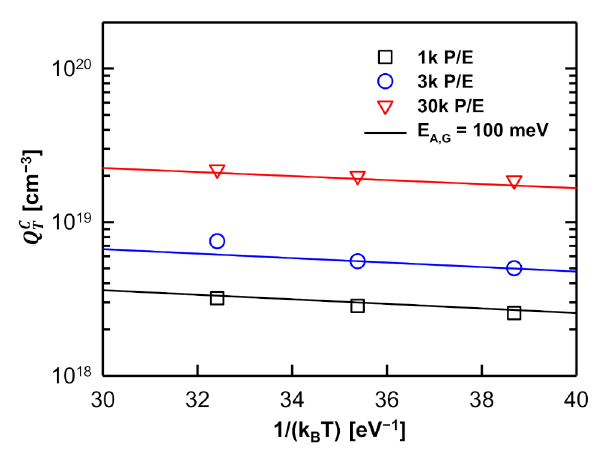
Figure 13. Q C obtained by fitting experimental data using Equation (5) for different values of T cyc . T Reprinted from